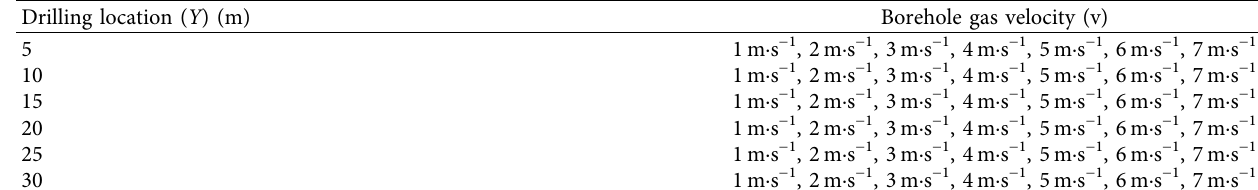
Table 3: Design scheme of numerical simulation parameters. Drilling location ( Y ) (m) Borehole gas velocity